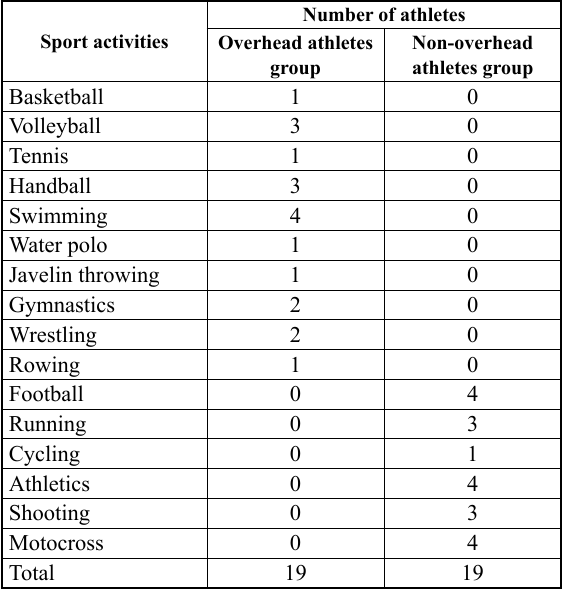
Table 1. Distribution of participants according to different sports activities Sport activities